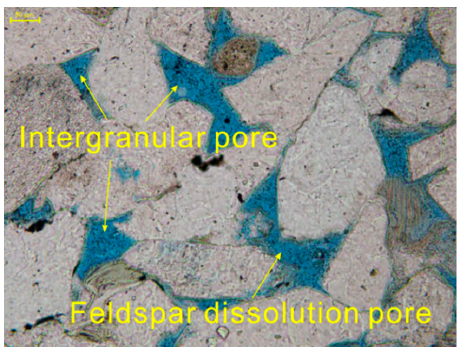
Figure 9. Intergranular pore and feldspar dissolution pore of the GSMFT type of pore-throat structure (Sample #11).